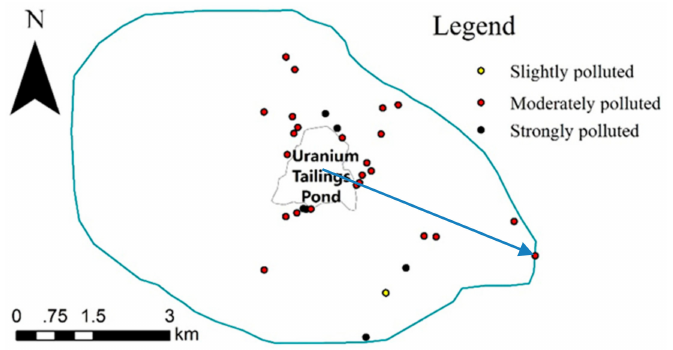
Figure 4. The distribution of the 31 samples whose CPI ≥